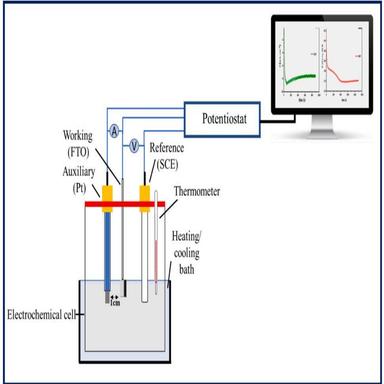
3D Formula and UV–vis spectrum of a solution of RhB (C28H31ClN2O3, Mass weight: 479.02 g/mol).